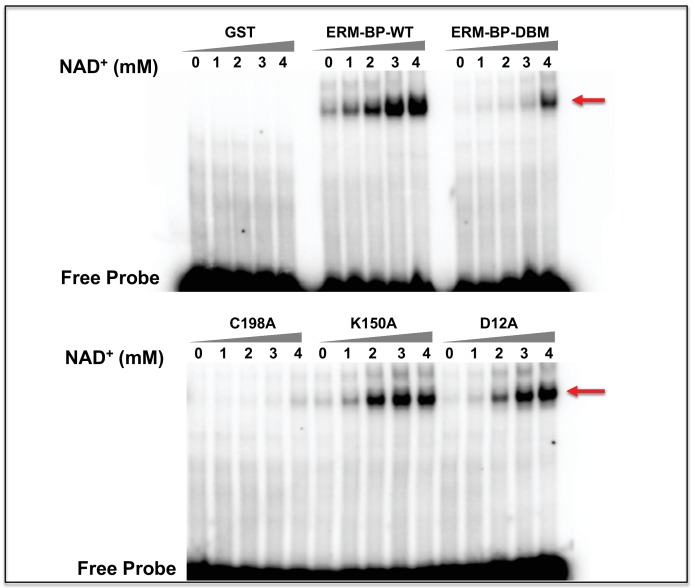
EMSA with recombinant proteins in the presence of varying concentrations of NAD+.Representative EMSA results by using recombinant ERM-BP-WT and mutant proteins (ERM-BP-DBM, C198A, K150A and D12A) with radiolabeled ERM in presence of different concentrations of NAD+ (0, 1, 2, 3 and 4 mM). EMSA shifted bands are shown by red arrows and free probes at the bottom. GST was used as negative control.